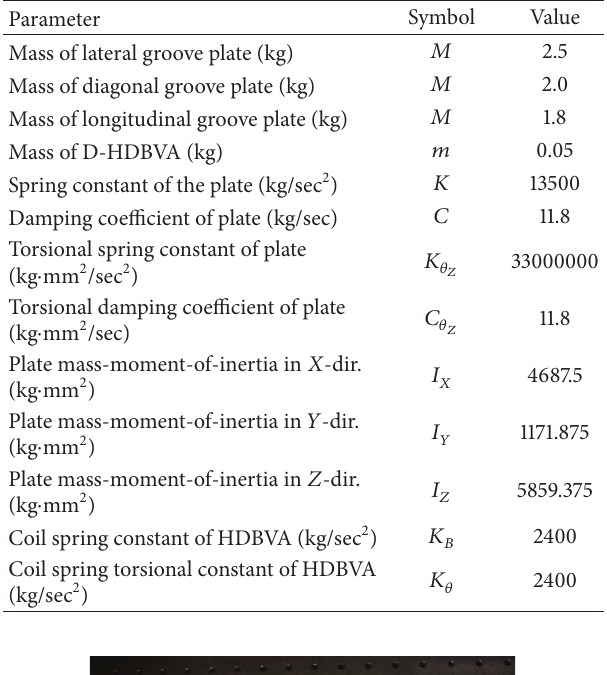
Table 1: Parameters in numerical simulations of rigid plate with vibration absorber.